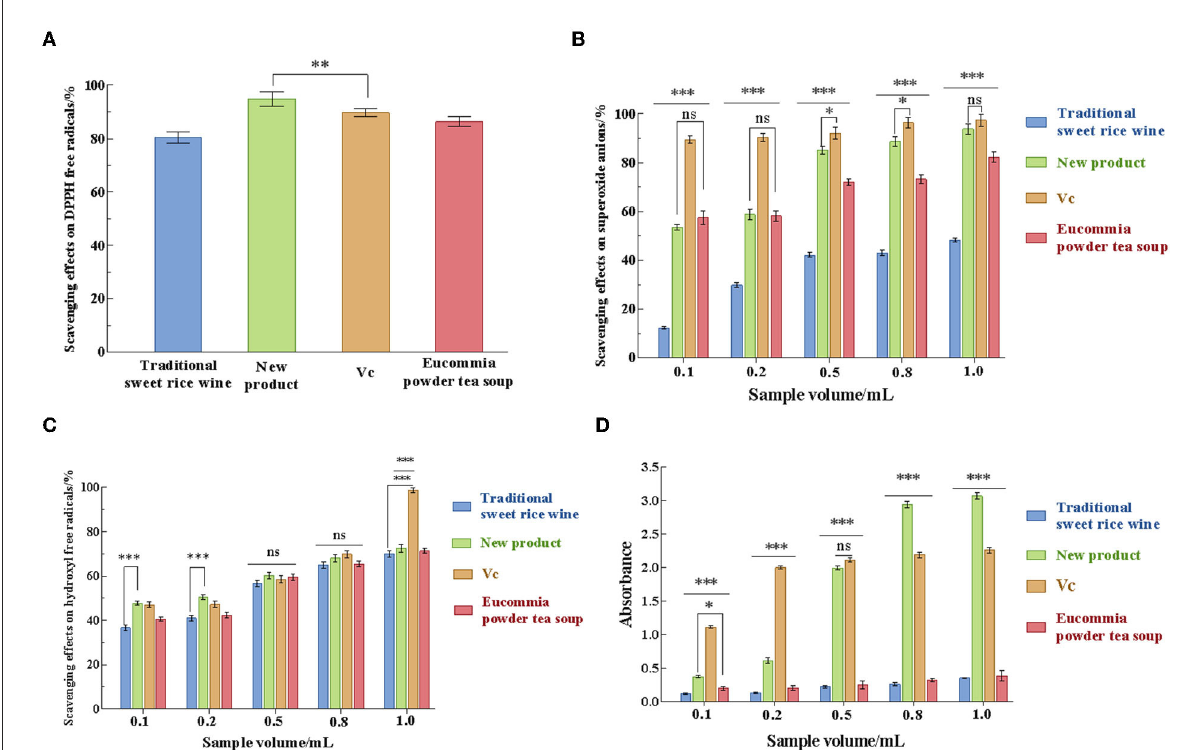
FIGURE6 Analysis of the antioxidant activity of traditional sweet rice wine, new product, Vc, and Eucommia ulmoides powder tea soup. (A) Scavenging effects on DPPH free radicals; (B) scavenging effects on superoxide anions; (C) scavenging effects on hydroxyl free radicals; and (D) reduction effects. ( n = 3). * p < 0.05; ** p < 0.01; *** p < 0.001.